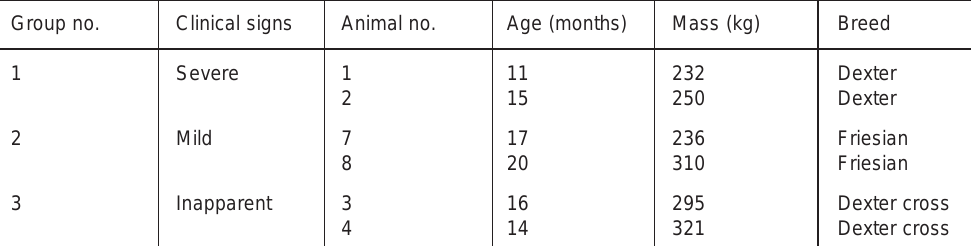
TABLE 1 Grouping of animals according to the severity of clinical signs Group